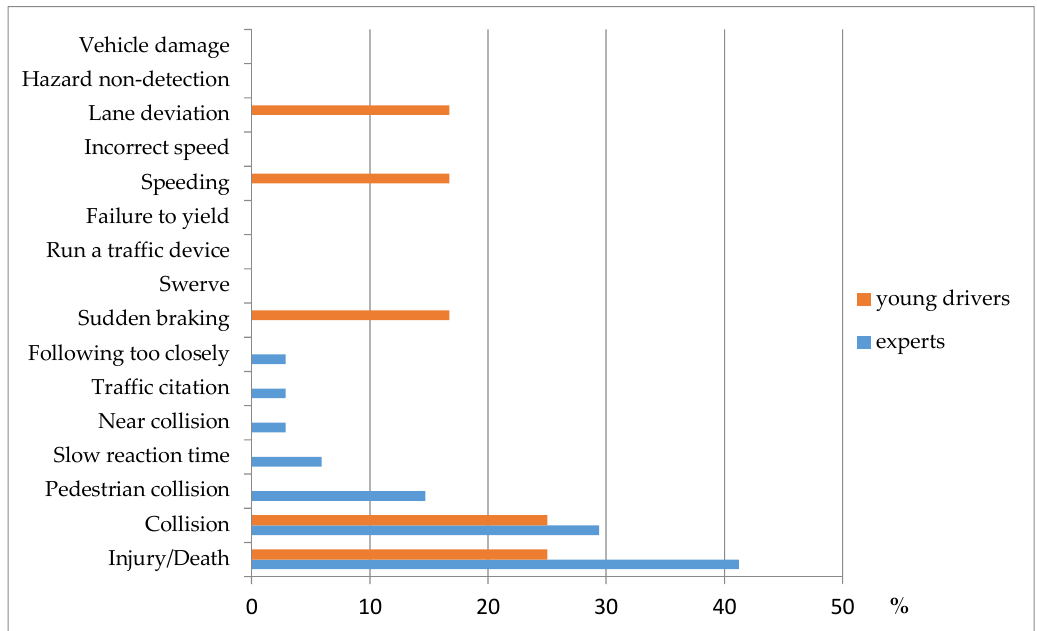
Figure 3. Consequential indicators of cellphone use while driving presented as a percent of total possible responses from experts and young drivers, United States, 2016.